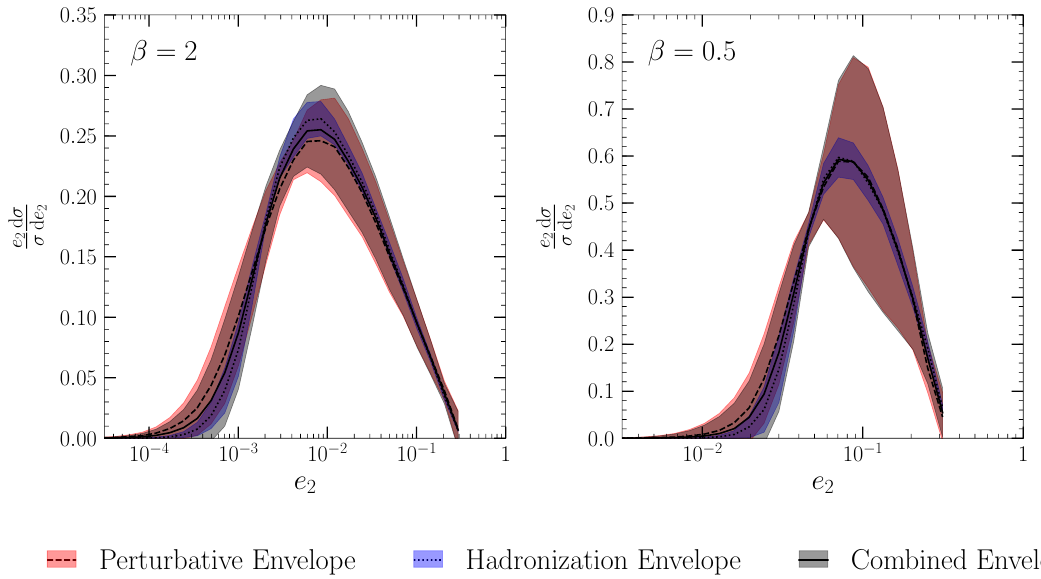
Figure 10 . Total theory uncertainties on the e 2 distributions for p T = 1 TeV jets for a dark sector whose model parameters are set to the benchmark values given in table 1 due to both perturbative and hadronization effects. Perturbative uncertainties are largest around the peak region, dominating at larger e 2 values. Hadronization uncertainties contribute most noticeably starting from the peak and extend down to smaller values of e 2 . Results are presented for two choices of the angular dependence: (cid:12) = 2 [left] and (cid:12) = 0 : 5